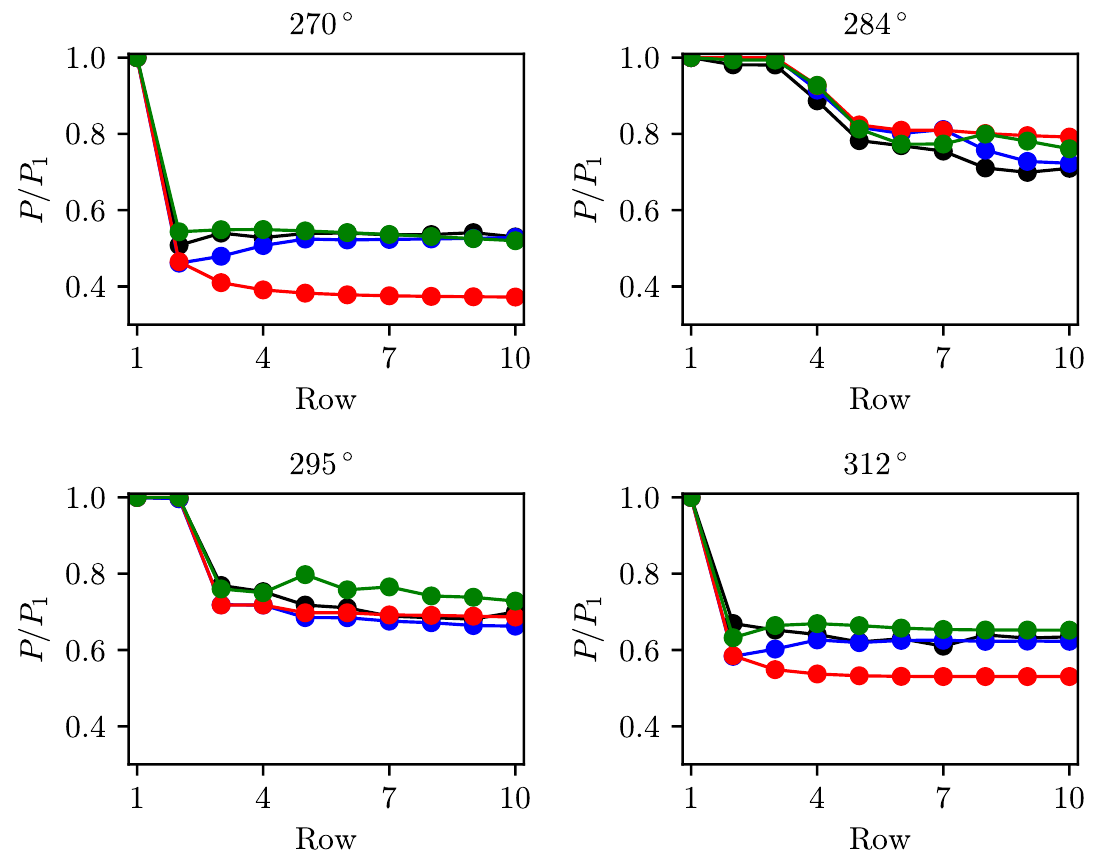
Figure 4. Wind farm power production of Columns 2–4 (counting from the south) at various wind angles from large-eddy simulations (LES) (black), the Jensen model (red), the coupled wake boundary layer (CWBL) (blue), and the present model (green). LES data were digitally extracted from